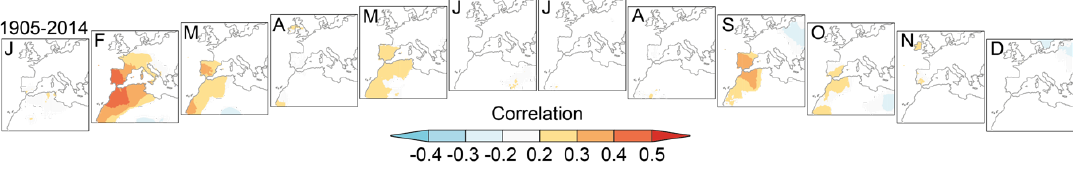
Figure 5. Correlation fields. Maps showing the spatial correlation patterns of the ABC300 chronology against gridded monthly temperatures (CRU TS4.03) from 1905–2014. Colored areas are significant at p <